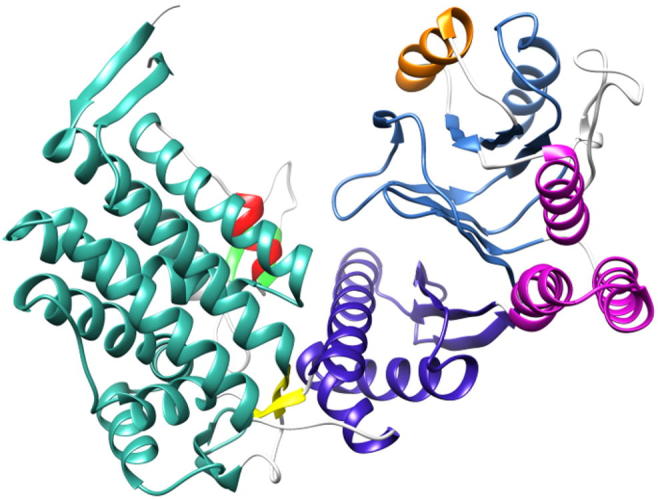
Rigid bodies (in different colors) identified by RIBFIND for the ADP bound GroEL structure (PDB: 4KI8) using a 32% cluster cutoff for merging secondary structures into rigid bodies [57]. White indicates regions that are not clustered.